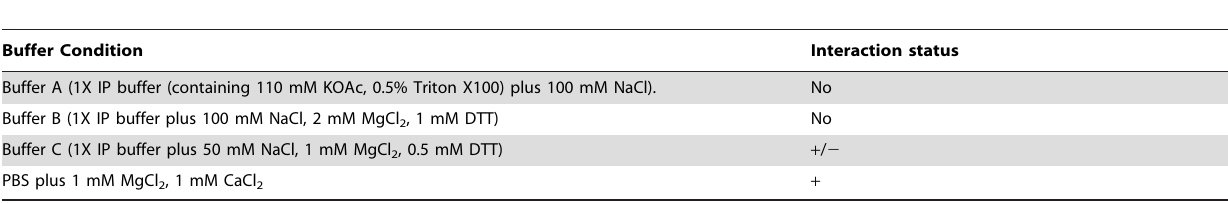
Table 1. Different buffer conditions used in the co-immunoprecipitation experiments and the interaction status of ERp46 and AdipoR1